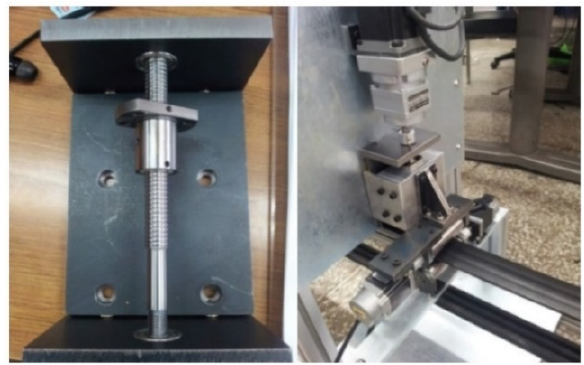
Figure 11. Mechanism for vertical movement of upper roller.